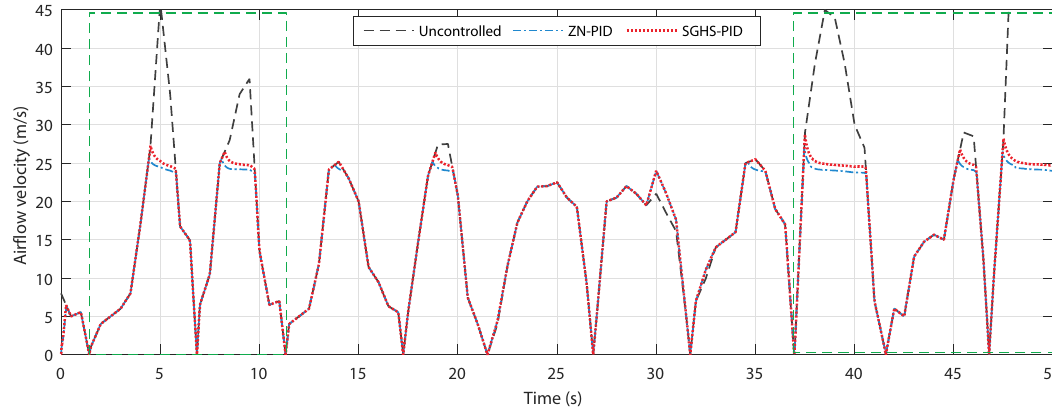
Figure 19. Airflow speed in uncontrolled and controlled cases with real wave data input.